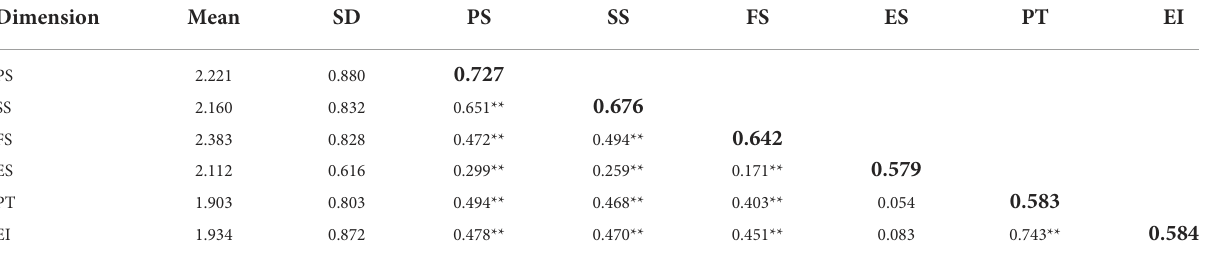
TABLE 2 Descriptive statistics and structural validity of the scale ( N = 436).